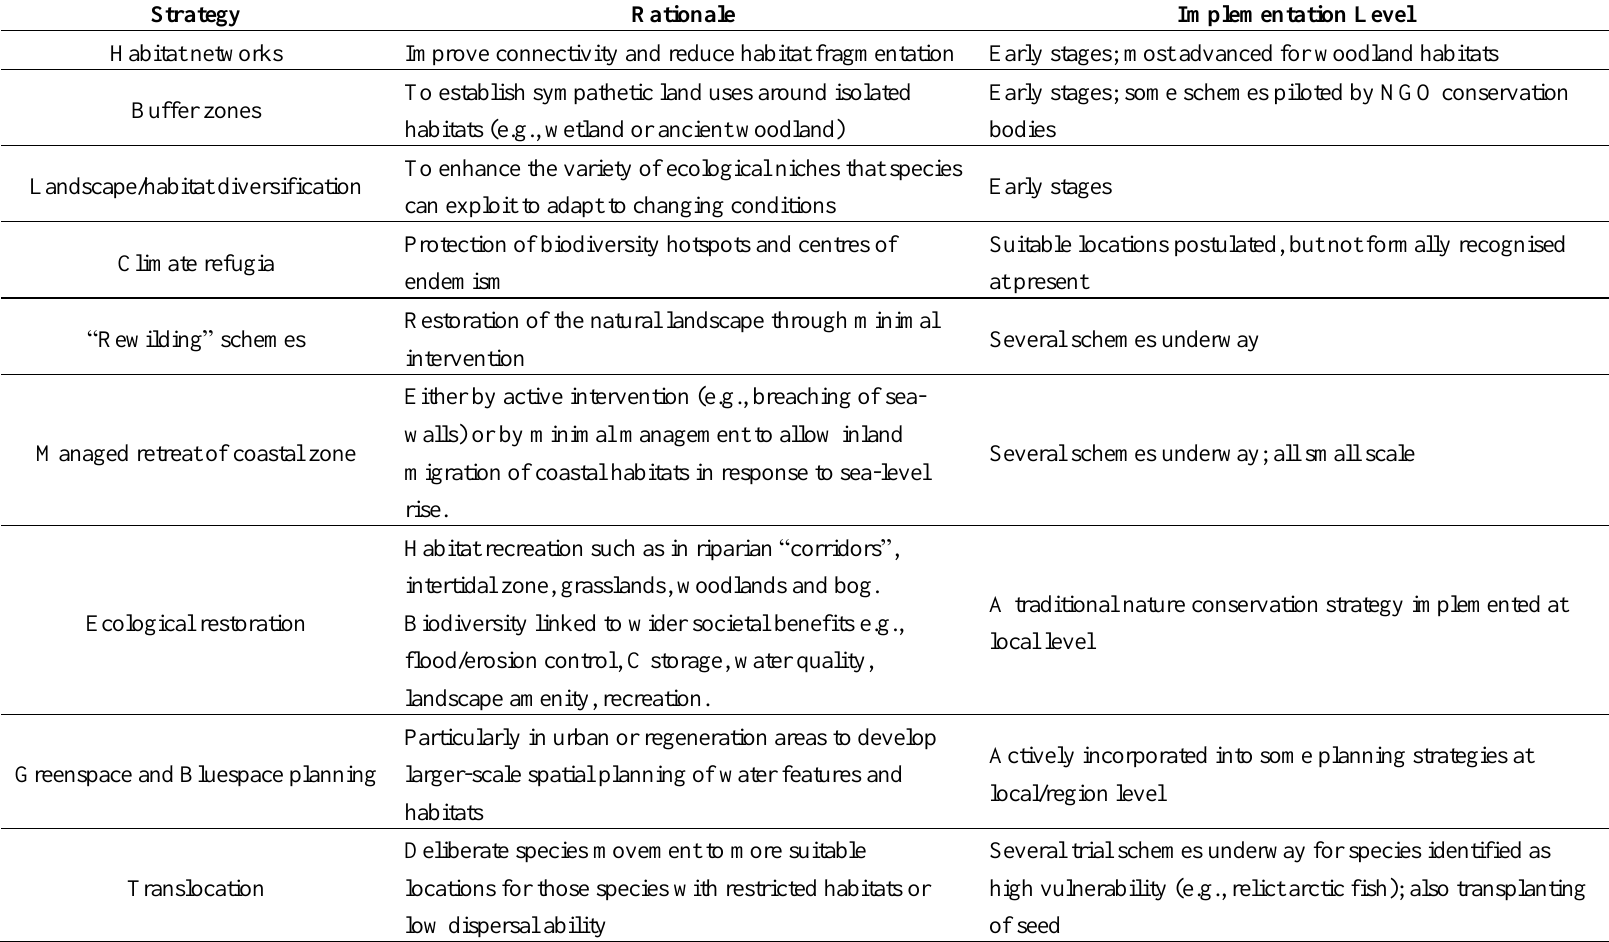
Table 5. Summary of general adaptation strategies for biodiversity and